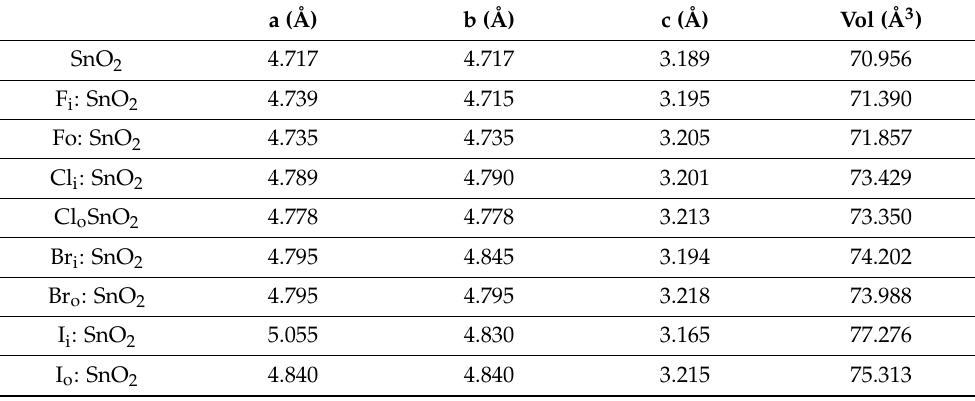
Figure 1. ( a ) F o : SnO 2 , ( b ) F i : SnO 2 , ( c ) Cl o : SnO 2 , ( d ) Cl i : SnO 2 , ( e ) Br o : SnO 2 , ( f ) Br i : SnO 2 , ( g ) I o : SnO 2 , ( h ) I i : SnO 2 . Table 1. The computed lattice parameters and cell volumes for every doping case.